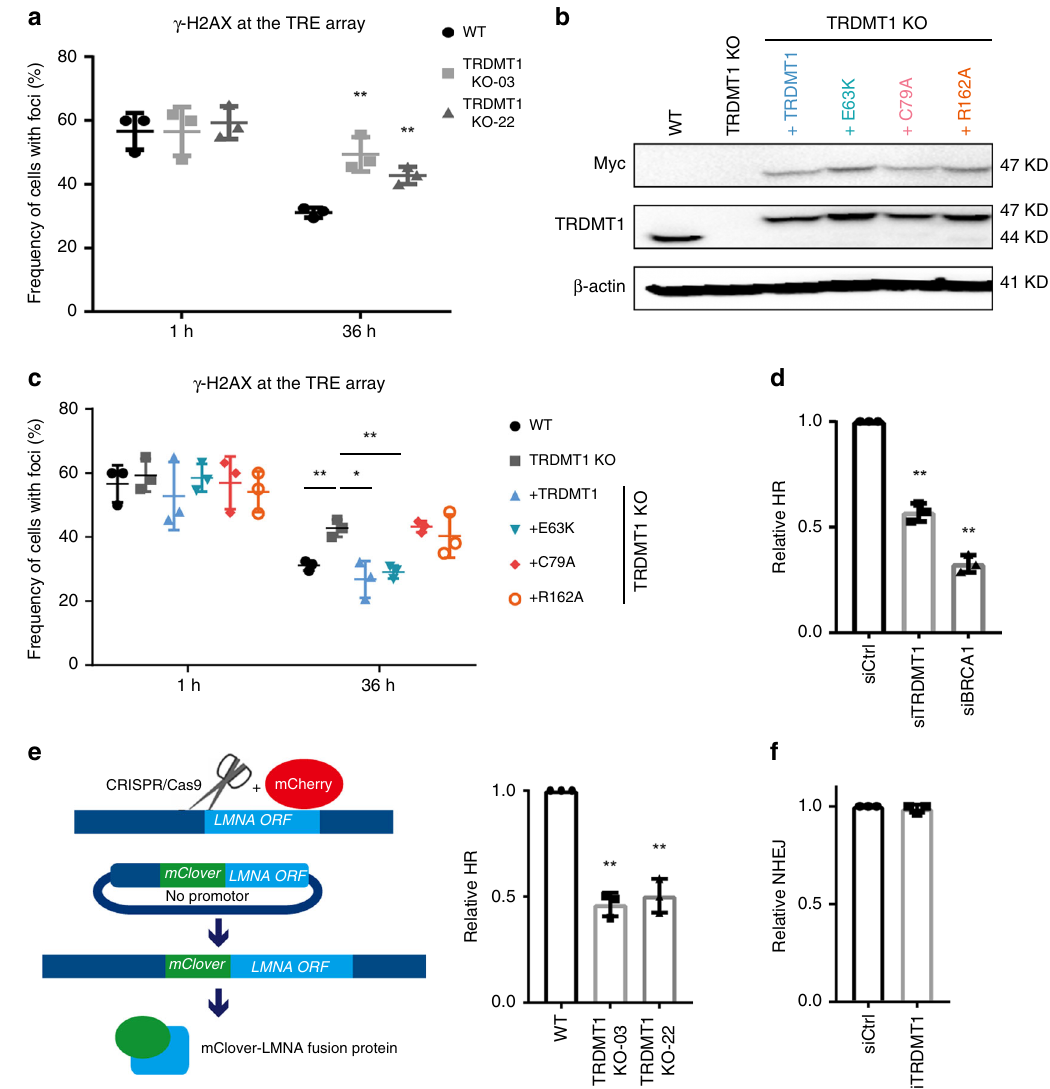
Fig. 3 TRDMT1 is required for damage removal and HR. a WT or TRDMT1 KO U2OS-TRE cells were transfected with TA-KR and stained for γ H2AX at the indicated timepoint after damage ( n = 3, mean ± SD). b Stable expression of Myc-tagged TRDMT1 in TRDMT1 KO U2OS-TRE cell lines shown in Western blots. Expression of β -actin is shown as a positive control. c U2OS-TRE WT, TRDMT1 KO, and TRDMT1 stably expressing cells were stained for γ H2AX after damage caused by TA-KR at the indicated timepoint ( n = 3, mean ± SD). d DR-GFP cells were pre-treated with siTRDMT1, siBRCA1, or control siRNA and then transfected with the NLS-I-SceI plasmid to induce DSBs. The GFP-positive population was analyzed by fl ow cytometry ( n = 3, mean ± SD). e WT or TRDMT1 KO U2OS cells were co-transfected with CRISPR/Cas9-sgLMNA, LMNA-mClover, and mCherry plasmids. The fraction of mClover-positive cells in the mCherry-positive population was analyzed by fl ow cytometry ( n = 3, mean ± SD). f EJ5-GFP cells were pre-treated with siTRDMT1 or control siRNA and then transfected with the NLS-I-SceI plasmid to induce DSBs. The GFP-positive population was analyzed by fl ow cytometry ( n = 3, mean ± SD). Statistical analysis was performed with the unpaired two tailed Student ’ s t -test. * p < 0.05; ** p < 0.01; *** p < 0.001; **** p <